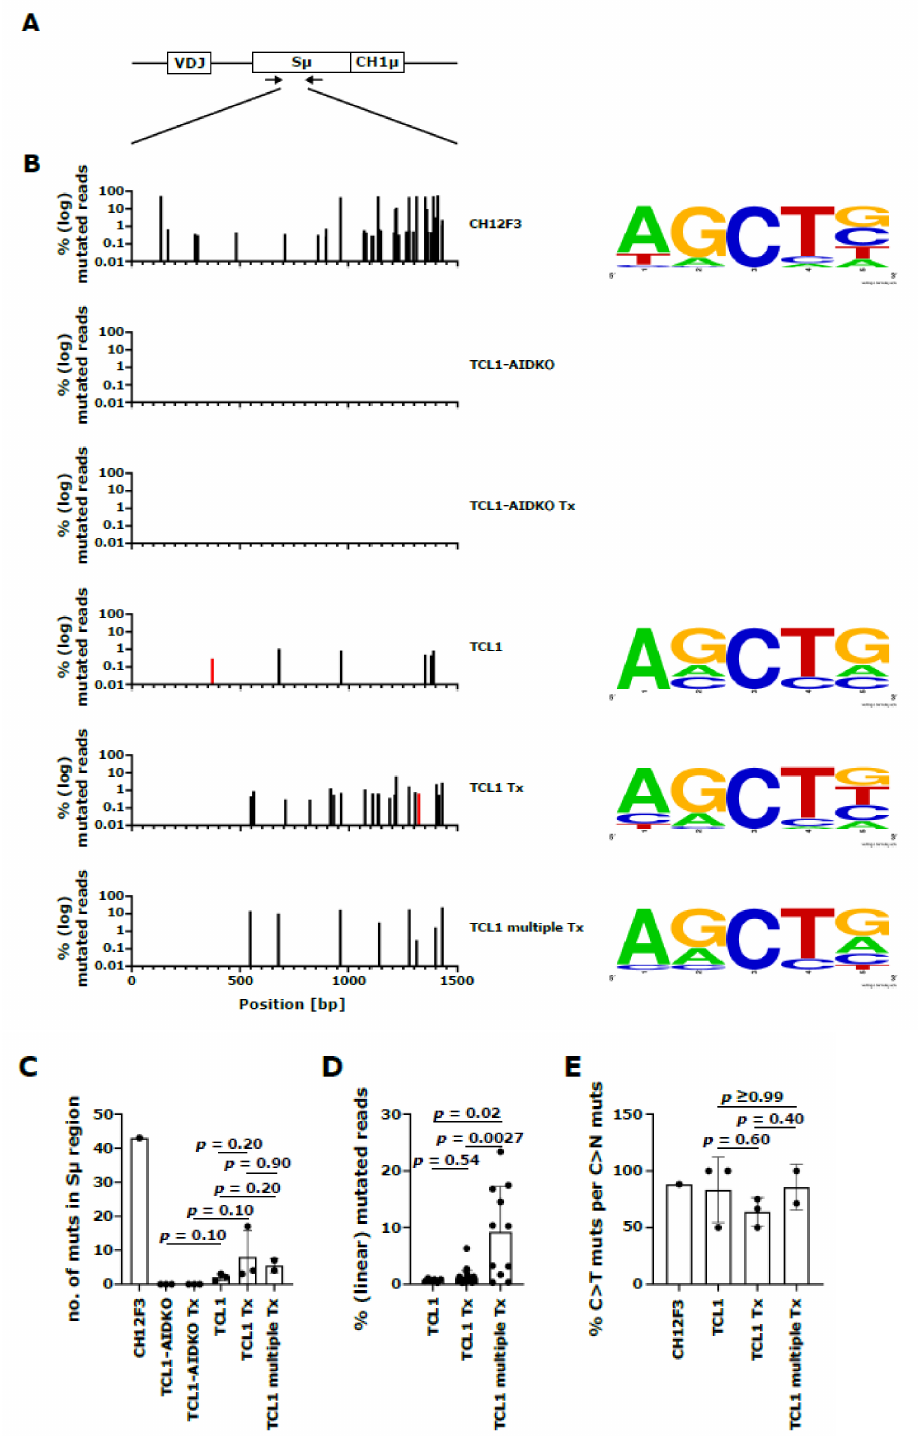
Figure 4. Mutation analysis of S µ region sequencing of primary (TCL1 and TCL1-AIDKO) and transplanted congenic recipient (TCL1 Tx, TCL1 multiple Tx and TCL1-AIDKO Tx) mice compared to stimulated CH12F3 cells. ( A ) A schematic representation of the IgH locus is indicated with the VDJ gene, the S µ region, and the first constant exon of the IgM heavy chain (CH1 µ ). DNA was subjected to PCR to amplify the S µ region. Primer-binding sites are indicated as arrows. ( B ) The graphs show mutations with a frequency above 0.1% at position 0 to 1500 bp of the amplified S µ sequence appearing within the sample groups of CH12F3 ( n = 1), TCL1-AIDKO ( n = 3), TCL1-AIDKO Tx ( n = 3), TCL1 ( n = 3), TCL1 Tx ( n = 3) and TCL1 multiple Tx ( n = 2) from top to bottom. The